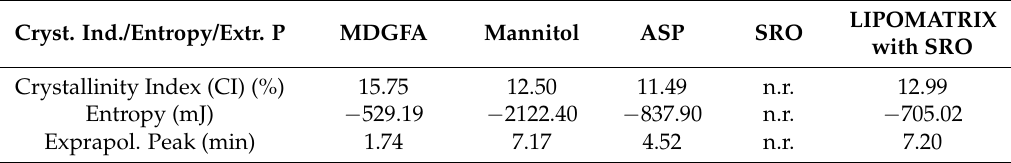
Figure 2. Overlapping thermograms of LIPOMATRIX containing SRO and single components. Black line represents ASP. Red line represents MDGFA. Green line represents Lipomatrix with SRO. Blue line represents Mannitol. Pink line represents SRO. Table 1. Cristallinity index, entropy, and extrapolation pick time of Lipomatrix and any of its constituents.